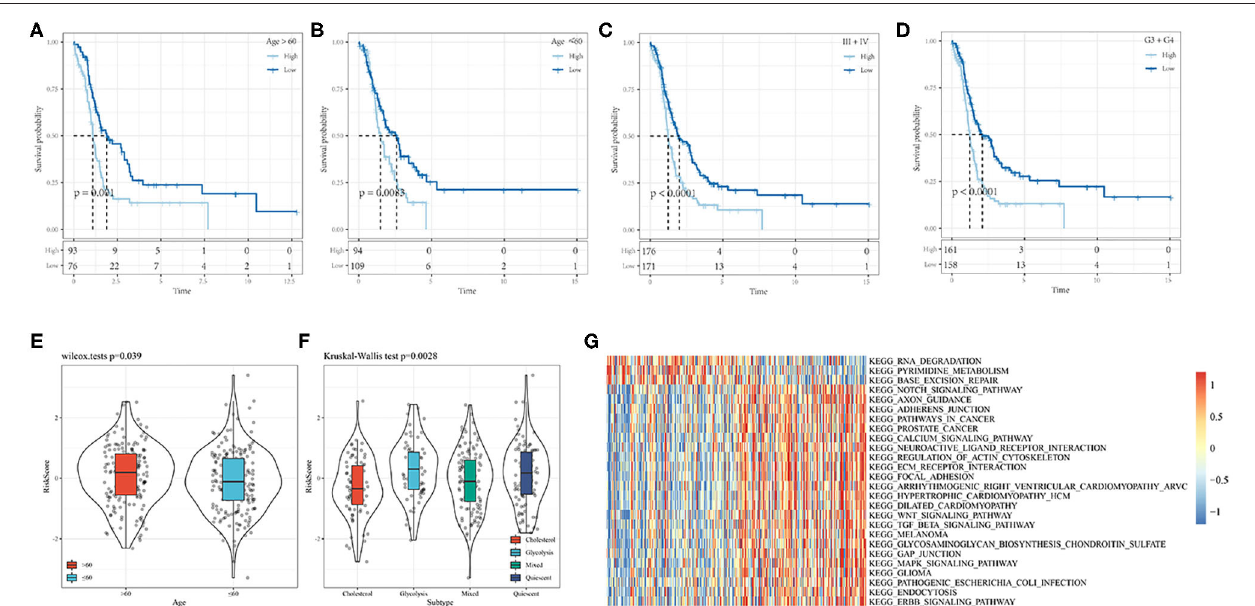
FIGURE 11 | (A,B) Comparison of prognosis of different Age groups based on Riskscore. (C) Comparison of prognosis of Stage III-IV based on Riskscore; (D) Comparison of prognosis of Grade 3 + 4 based on Riskscore; (E) Correaltion of RiskScore between samples in Age groups; (F) Correaltion of RiskScore between samples in molecular subtype groups; (G) Heat map of the relationship between risk score and biological function.